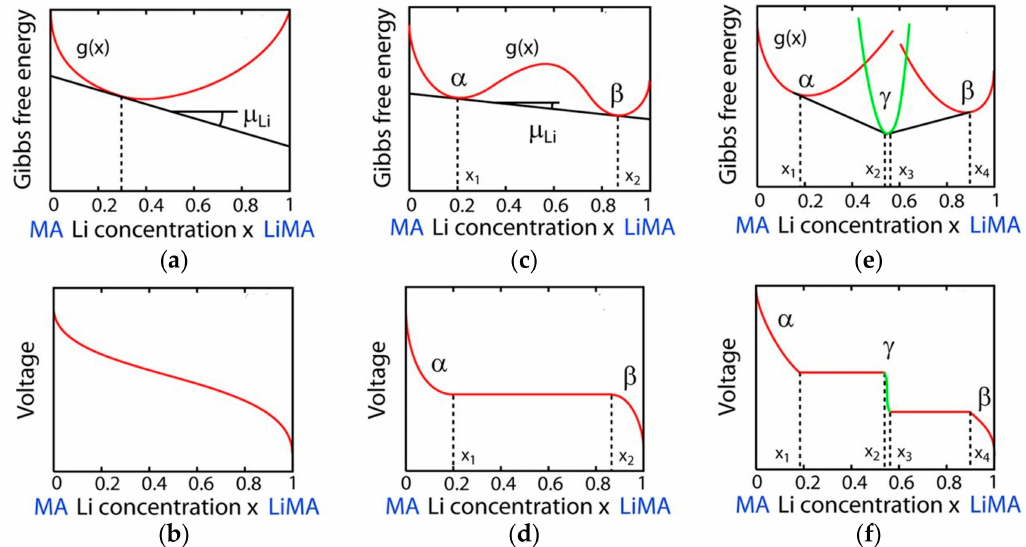
Figure 3. ( a – f ) The relationship between voltage curves and the slope of the free energy (Reproduced with permission from [49], Copyright 2013, American Chemical